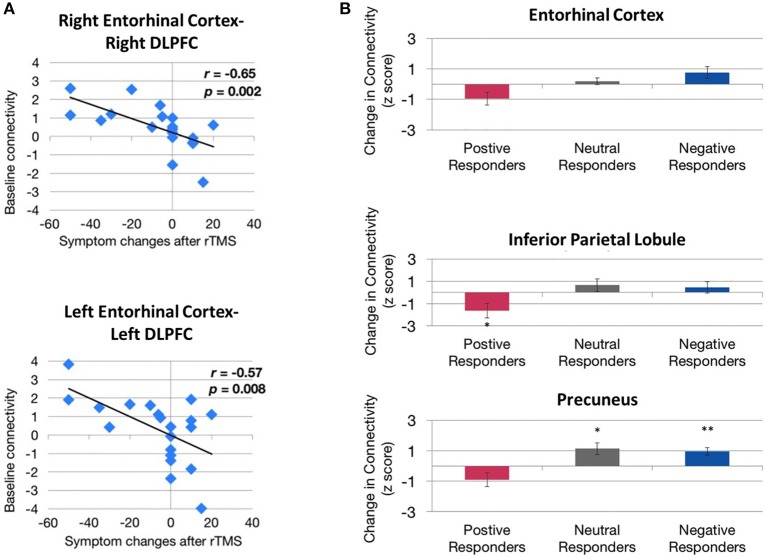
Evidence of correlation between behavioral improvements and functional connectivity before and after rTMS treatment. (A) Correlation between baseline entorhinal cortex–dorsolateral prefrontal cortex (DLPFC) functional connectivity and treatment response. Higher baseline functional connectivity exhibited by both right entorhinal cortex–right DLPFC connectivity (top) and left entorhinal cortex–left DLPFC connectivity (bottom) is associated with a greater magnitude of symptom reduction (change < 0) after rTMS. (B) Directional effect of functional connectivity changes between the left entorhinal cortex and the right entorhinal cortex (top), right inferior parietal lobule (middle), and the left precuneus (bottom). Functional connectivity between these regions decreased in patients showing improvement in symptoms (positive responders) compared with patients whose symptoms remained unchanged (neutral responders) or worsened (negative responders). *,**Indicate significant changes for p < 0.05 and p < 0.01, respectively. Image from Yuan et al. (2017), an open access article distributed under the terms of the Creative Commons Attribution License, which permits unrestricted use, distribution, and reproduction in any medium, provided the original work is properly cited.